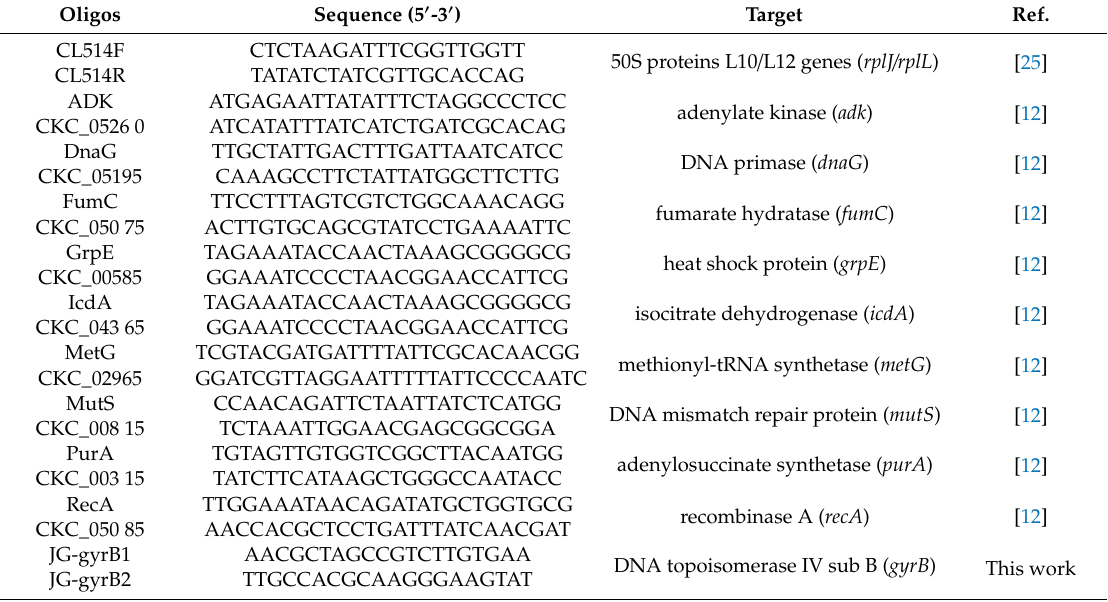
Table 3. Primers used in PCRs for haplotype